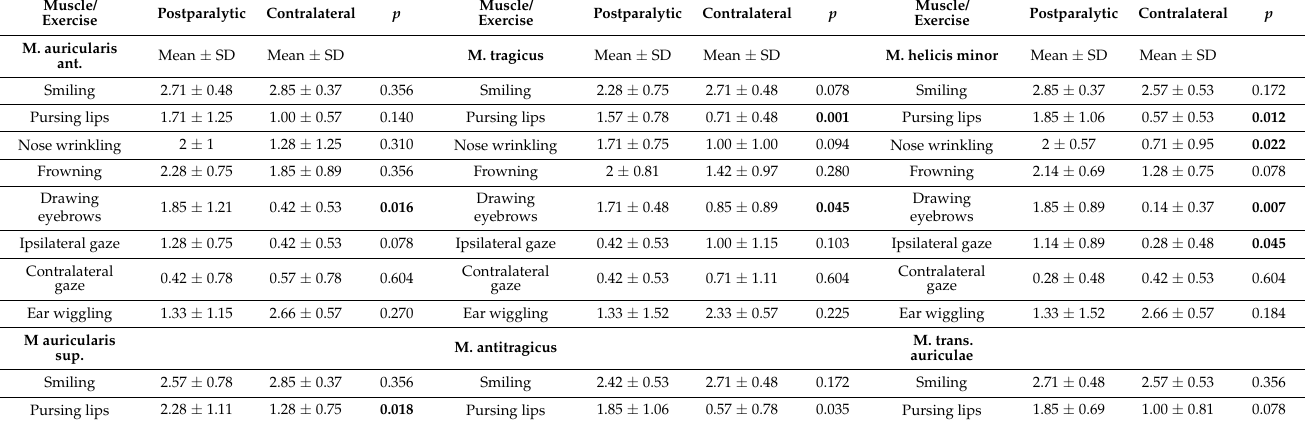
Table 3. Patients with postparalytic facial synkinesis: average surface single-channel EMG activity * in the different ear muscles during mimic tasks on postparalytic and contralateral